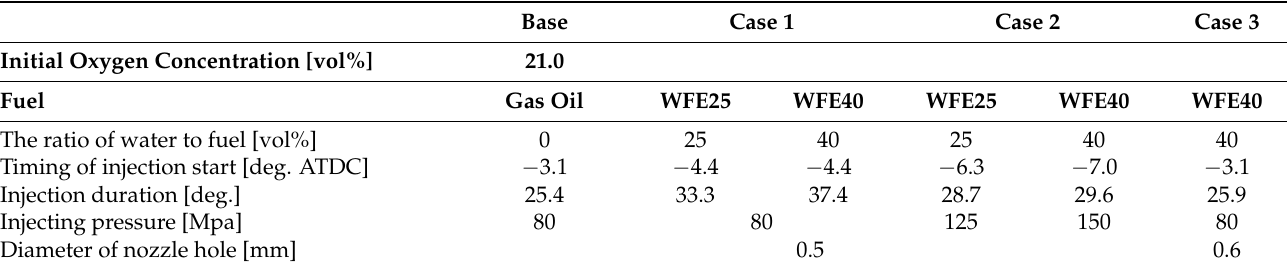
Table 2. Experimental conditions of the WFE.